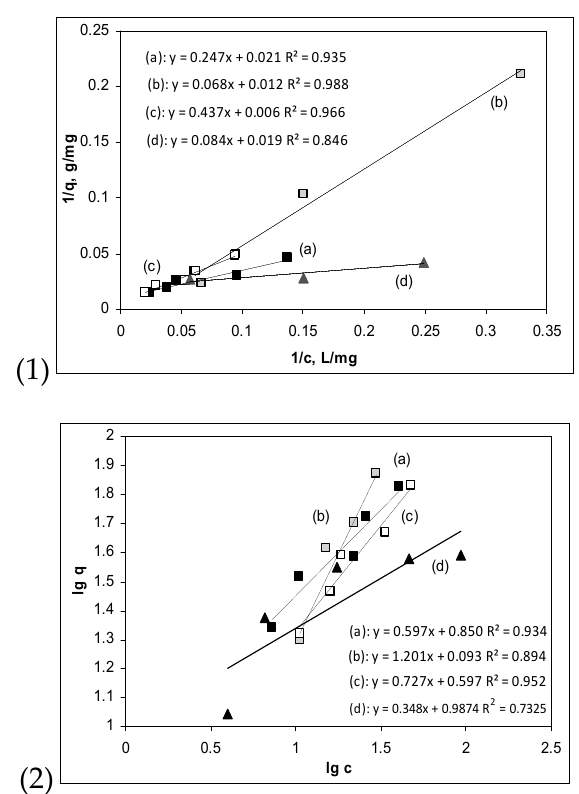
Figure 6. Linear representation of Langmuir isotherm model ( 1 ) and Freundlich isotherm model ( 2 ) for the adsorption of Cu(II) ions on studied adsorbent materials (( a ): RAB; ( b ): AWB; ( c ): Alg; ( d ): Fe-NPs-Alg). Table 3. Isotherm parameters for Cu(II) ions adsorption on considered adsorbent materials.